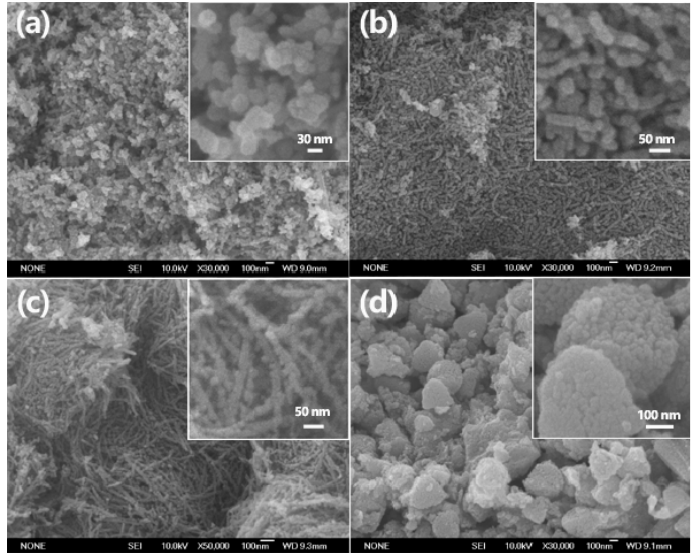
Figure 2. Scanning electron microscopy (SEM) images (secondary electron imaging mode) of